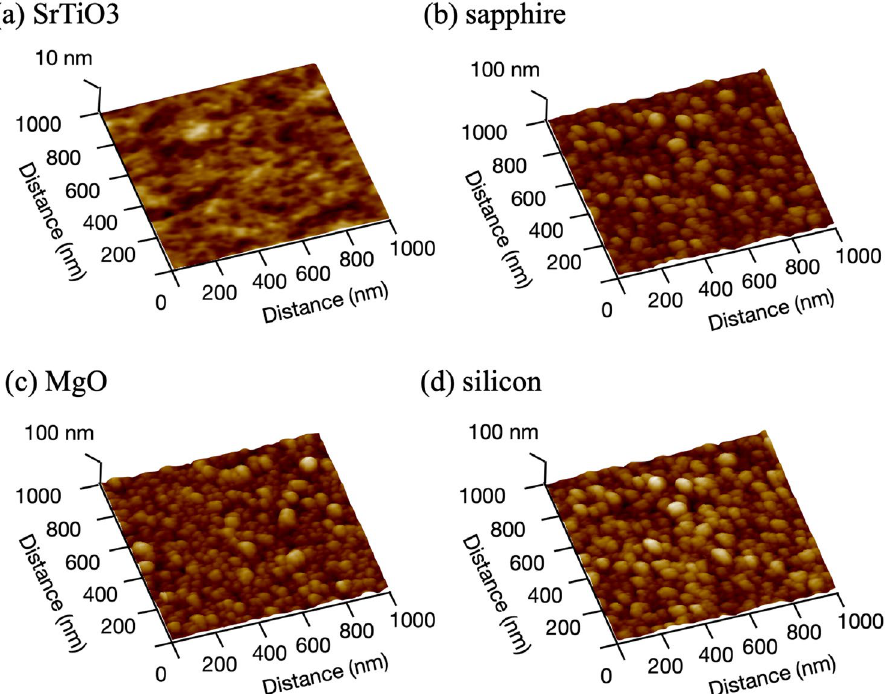
Figure 5. AFM images of film deposited on various substrates; ( a ) strontium titanate (SrTiO 3 (001)), ( b ) sapphire (Al 2 O 3 (001)), ( c ) magnesium oxide (MgO(001)), ( d ) silicon (Si(001)) substrates. Flat surface grew on SrTiO 3 and nano balls grew on Si substrate.